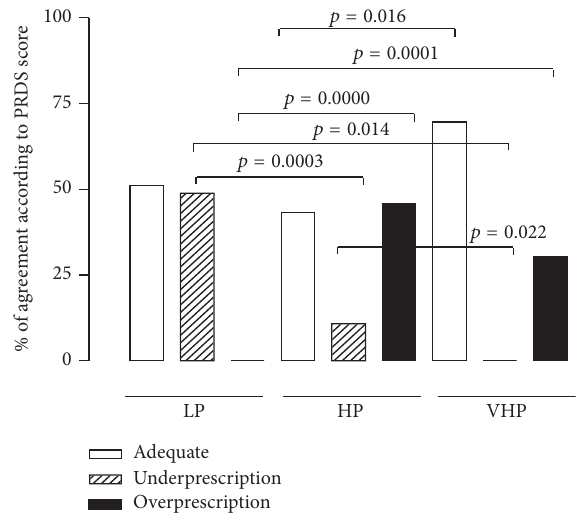
Figure 2: Percentage of adequate prescription (white bars), under- prescription (row bars), and overprescription (black bars) of PR rehabilitation in the LP, HP, and VHP groups according to the PRDS cut-off values proposed (LP: 0–10, HP: 11–17, and VHP: 18–34). A test of proportion (test Zeta) was performed to compare differences in the percentage of appropriate prescription, underprescription, and overprescription of PR as decided by the specialist at the outpatient visit. A 𝑝 value < 0.05 was considered statistically